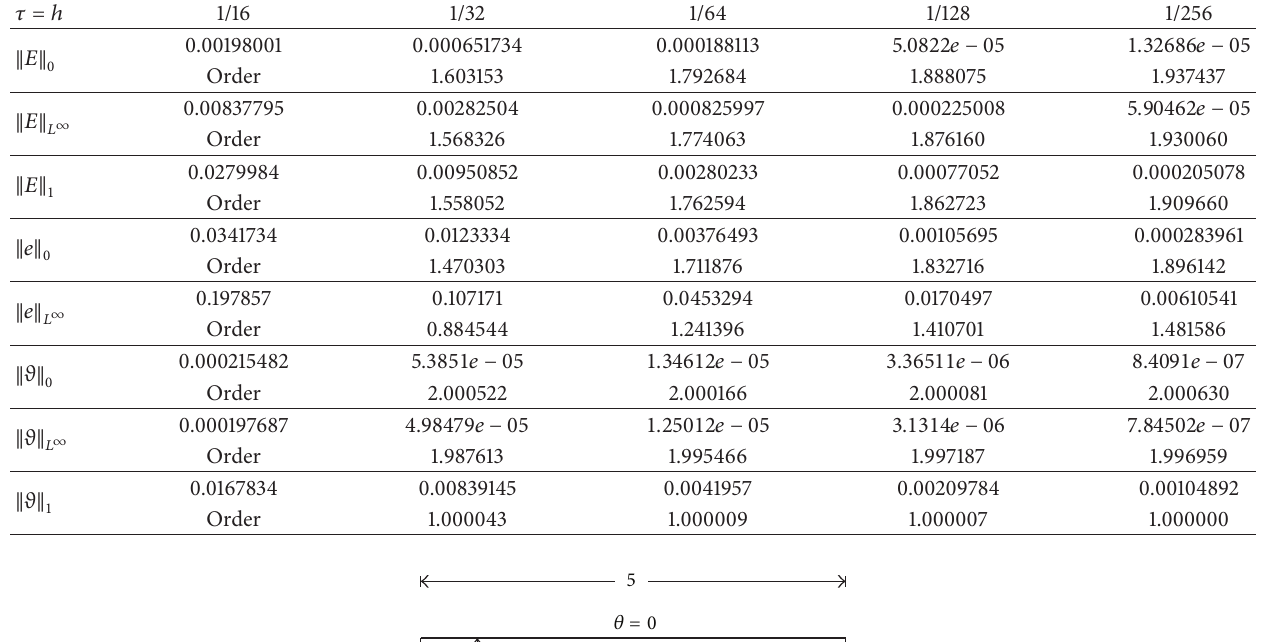
Figure 1: Example 20: initial and boundary values of B´enard convection